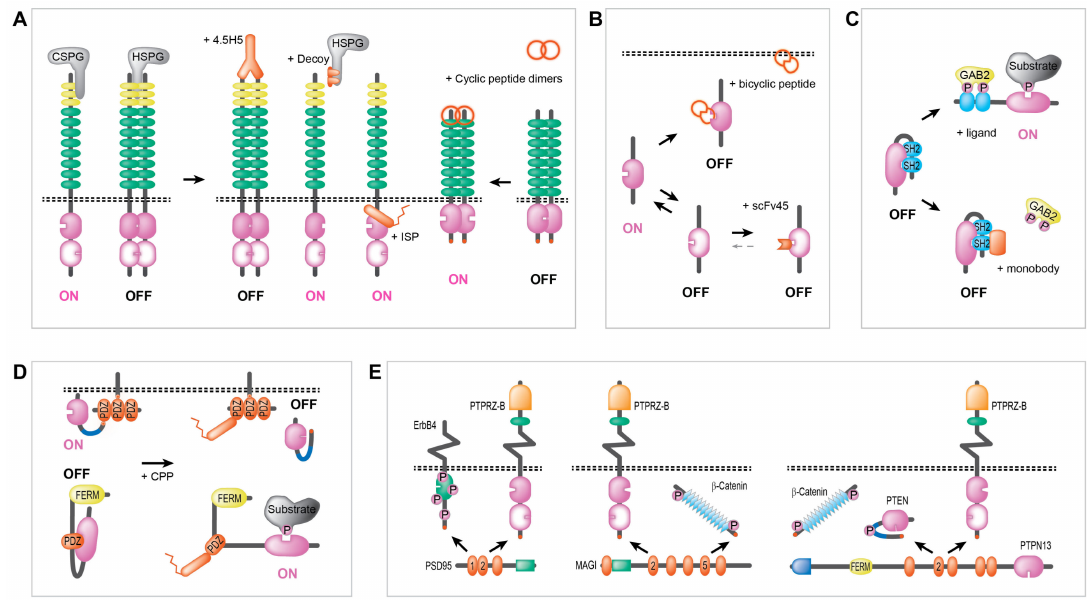
Figure 4. Current examples of proteinaceous PTP modulators. ( A ) Regulation of RPTP σ activity by CSPG or HSPG ligands, dimerizing antibodies (4.5H5), dimerization-blocking decoy receptors or a cell-penetrating “wedge” peptide (ISP). In addition, cyclic peptide dimers that activate CD148 are shown. ( B ) Inhibition of PTP1B activity by a bicyclic peptide containing a cell-penetrating and an enzyme-inhibiting peptide loop, or by an intracellular single-chain variable fragment (scFv45) that stabilizes the partly oxidized, inactive form of the enzyme. ( C ) Abrogation of the ligand-induced activation of SHP2 using a monobody that blocks SH2 domain interactions with the ligand. ( D ) Interfering with PDZ-mediated regulatory principles. Cell-penetrating peptides (CPP) prevent PTEN recruitment to the postsynaptic density (upper half) or activate PTPN4 in glioblastoma cells (lower part). ( E ) Schematic depiction of targetable submembranous PDZ-based interactions in glioblastoma cells. PTEN, PTPRZ-B, ErbB4 and β -catenin all can interact with PSD95, MAGI family members and PTPN13 PDZ domains. Associations may be mutually exclusive, as for PTEN and PTPRZ-B binding to PTPN13 PDZ2, or additive. The ErbB4 TK domain is in green, blue diamonds represent β -catenin armadillo repeats, and the green rectangle indicates the membrane-associated guanylate kinase domain in PSD95 and MAGI proteins. Other protein domains are explained in Figure 1. See the text for more details and